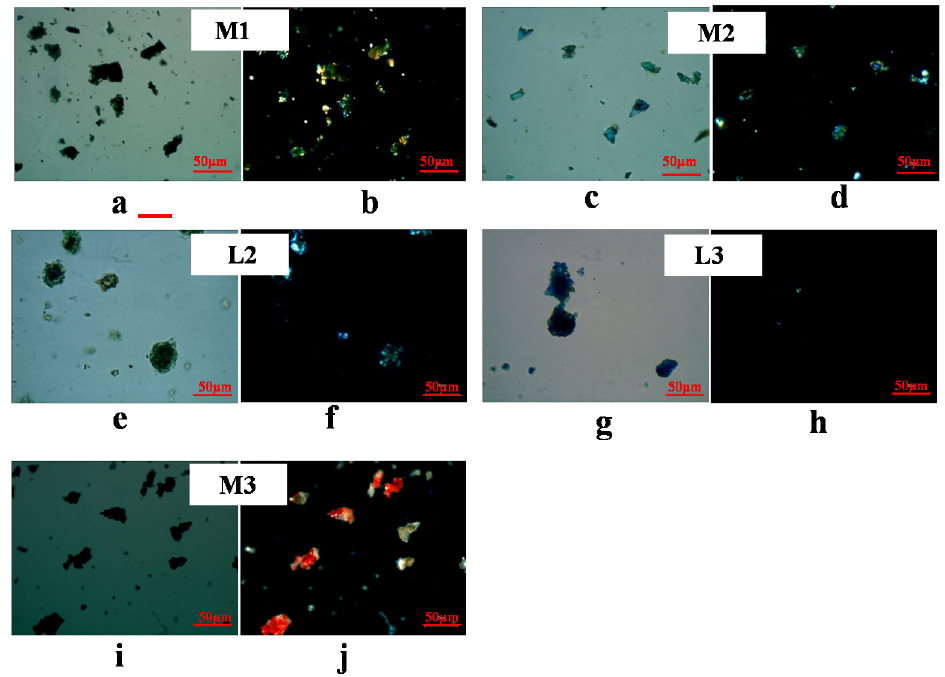
Figure 5. Pictures ( a , c , e , g , i ) are horizontal polarized light. Pictures ( b , d , f , h , j ) are perpendicular polarized light. M1: polarized light microscopy (PLM) image of atacamite; M2: PLM image of azurite; L2: PLM image of emerald green; L3: PLM image of ultramarine; M3: PLM image of cinnabar. Table 3. Elemental composition of the samples. Main Elements of EDX Spectrum (wt.%)